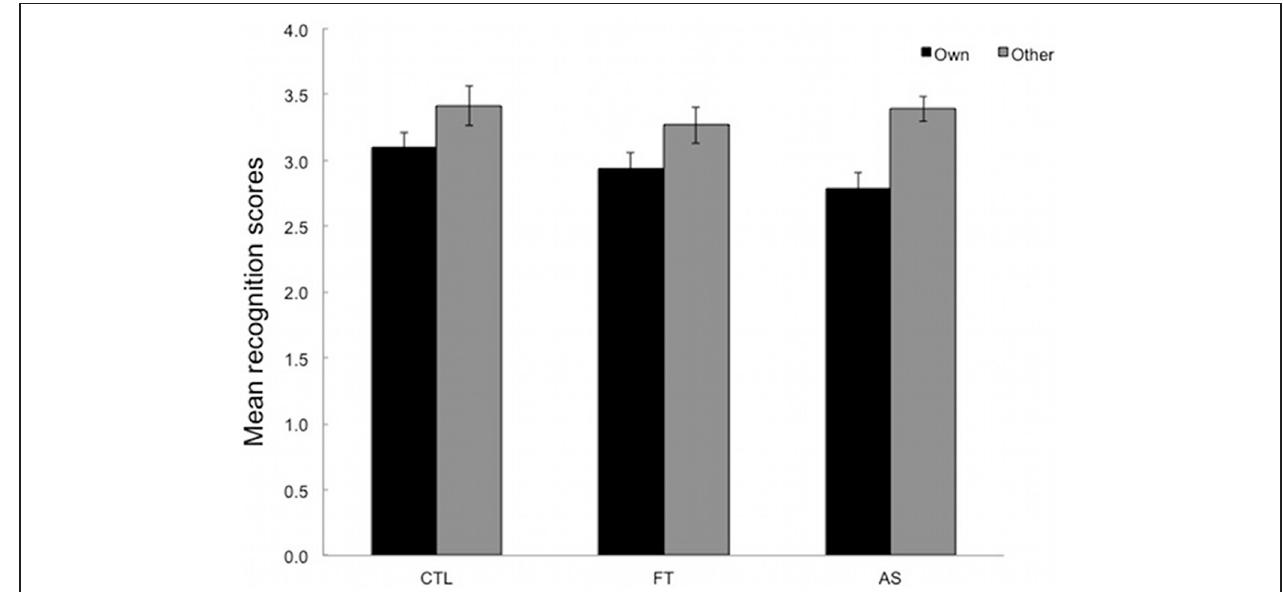
FIGURE 3 | Mean recognition ratings given for the 24 test triplets, plotted separately for the three conditions: articulatory suppression, foot tapping, and control. Low ratings (between